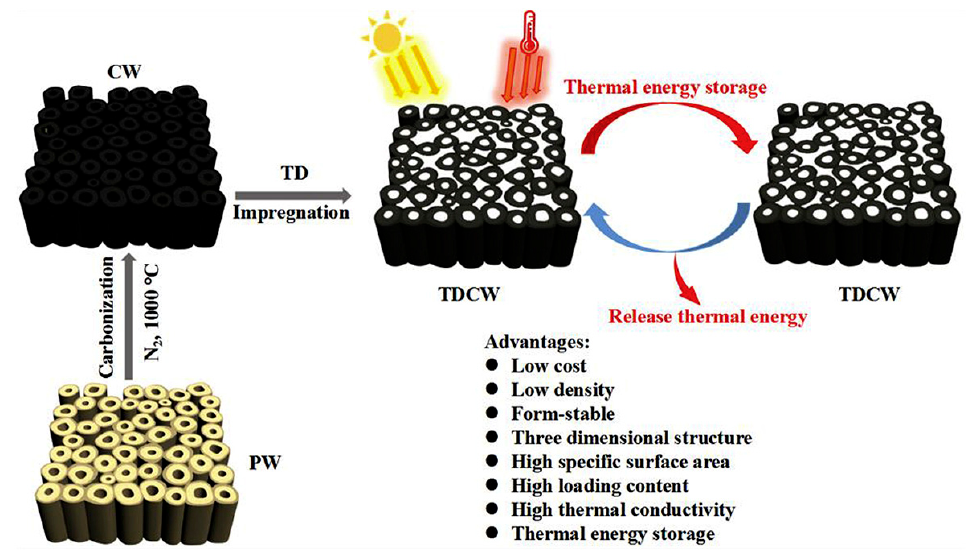
Figure 12. Diagram showing the carbonization of wood/impregnation of TD mechanism and formation of TDCW. The advantages of this strategy and thermal energy storage/release cycle are also mentioned. TD = 1-tetradecanol, TDCW is PCM composite made of 1-tetradecanol and carbonized wood. Adopted after permission [52], copyright 2018, Elsevier BV. Table 3. Physicochemical parameters of selected PCM materials discussed in this section.